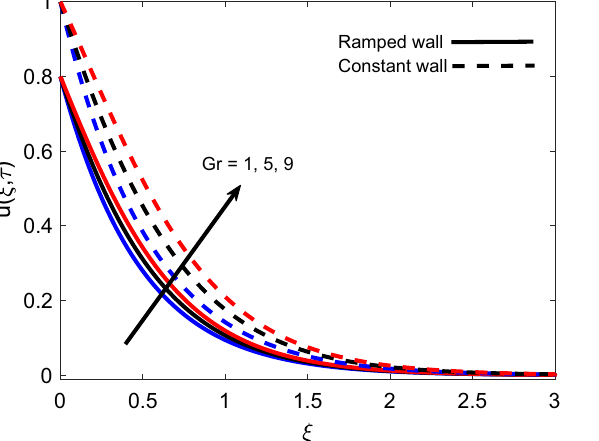
Figure 9. Velocity distribution for various values of Gr